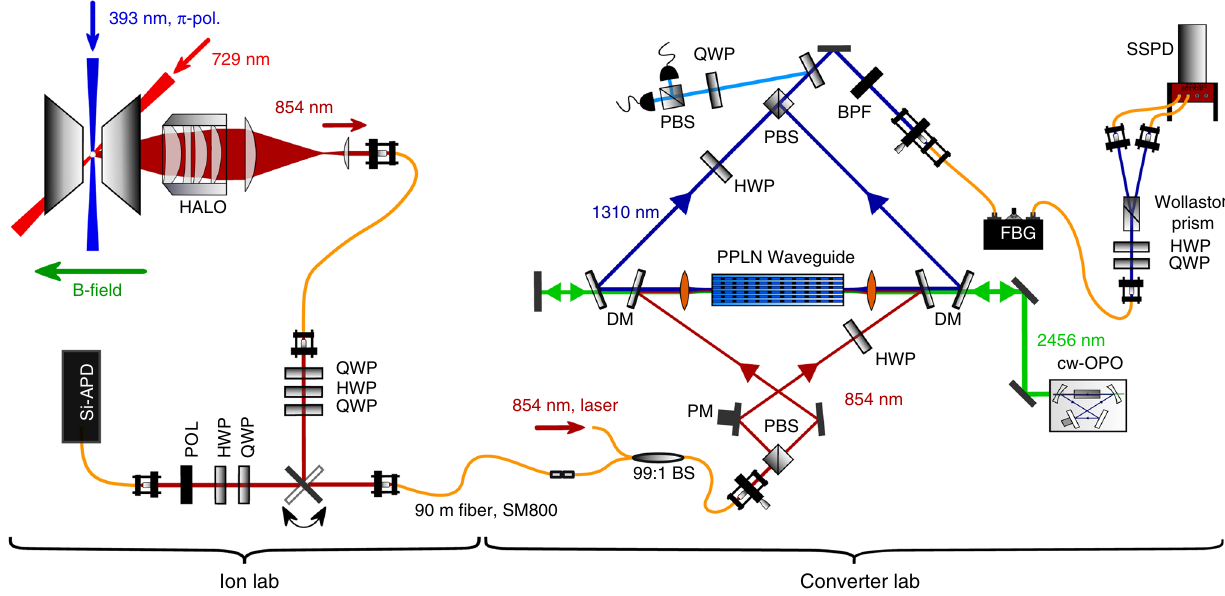
Fig. 1 Experimental setup. Atom – photon entanglement is generated between a single trapped 40 Ca + -ion, con fi ned and laser-cooled in a linear Paul trap, and a single photon at 854 nm. The photons are collected with a HALO ( “ High-numerical-Aperture Laser Objective ” ) and coupled to a single-mode fi ber. A combination of two quarter waveplates (QWP) and one half wave plate (HWP) is inserted behind the fi ber to compensate all unitary rotations of the polarization state caused by the single-mode fi ber and several dichroic mirrors between the fi ber and the HALO. A fl ip mirror can be inserted behind the fi ber to send the photons either to the converter lab via a 90 m long single-mode fi ber or to the projection setup for 854nm. The polarization-preserving frequency converter is realized with a nonlinear waveguide crystal in a single-crystal Mach – Zehnder con fi guration (for details see main text and Methods). The converted photons are detected with superconducting single-photon detectors. PBS polarizing beam splitter, DM dichroic mirror, BS beam splitter, BPF band pass fi lter, FBG fi ber Bragg